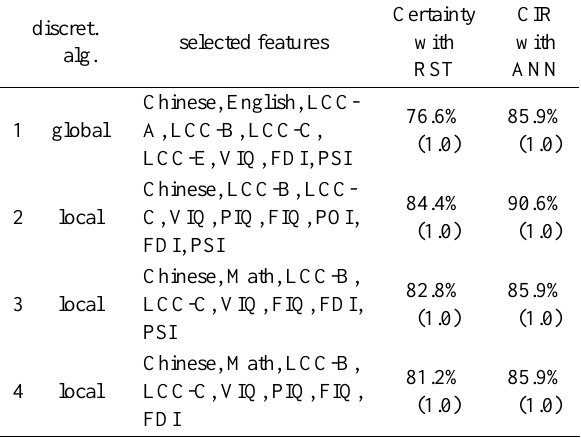
Table 7. Selected feature sets and their corresponding best certainty/CIR with data set B. (The number within parenthesis represents the coverage of the prediction.) discret.